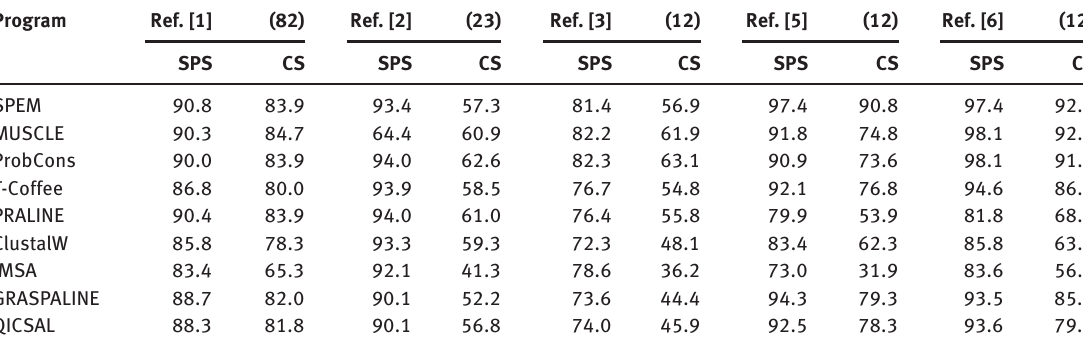
Table 3. BaliScore CS and SP Score Results of